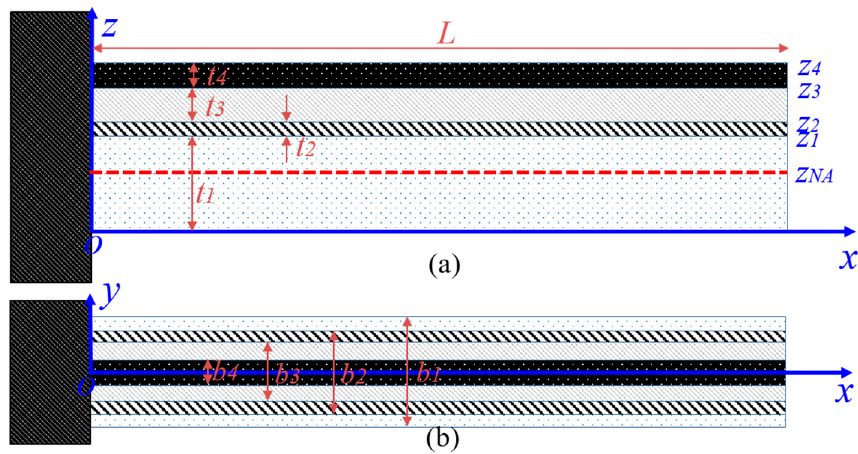
Figure 2. Definition of the coordinate of the four-layer piezoelectric cantilever—the first layer is the substrate, the third layer is the piezoelectric layer, and the second and fourth layer are electrodes; ( a ) side ‐ view; ( b ) top ‐ view.